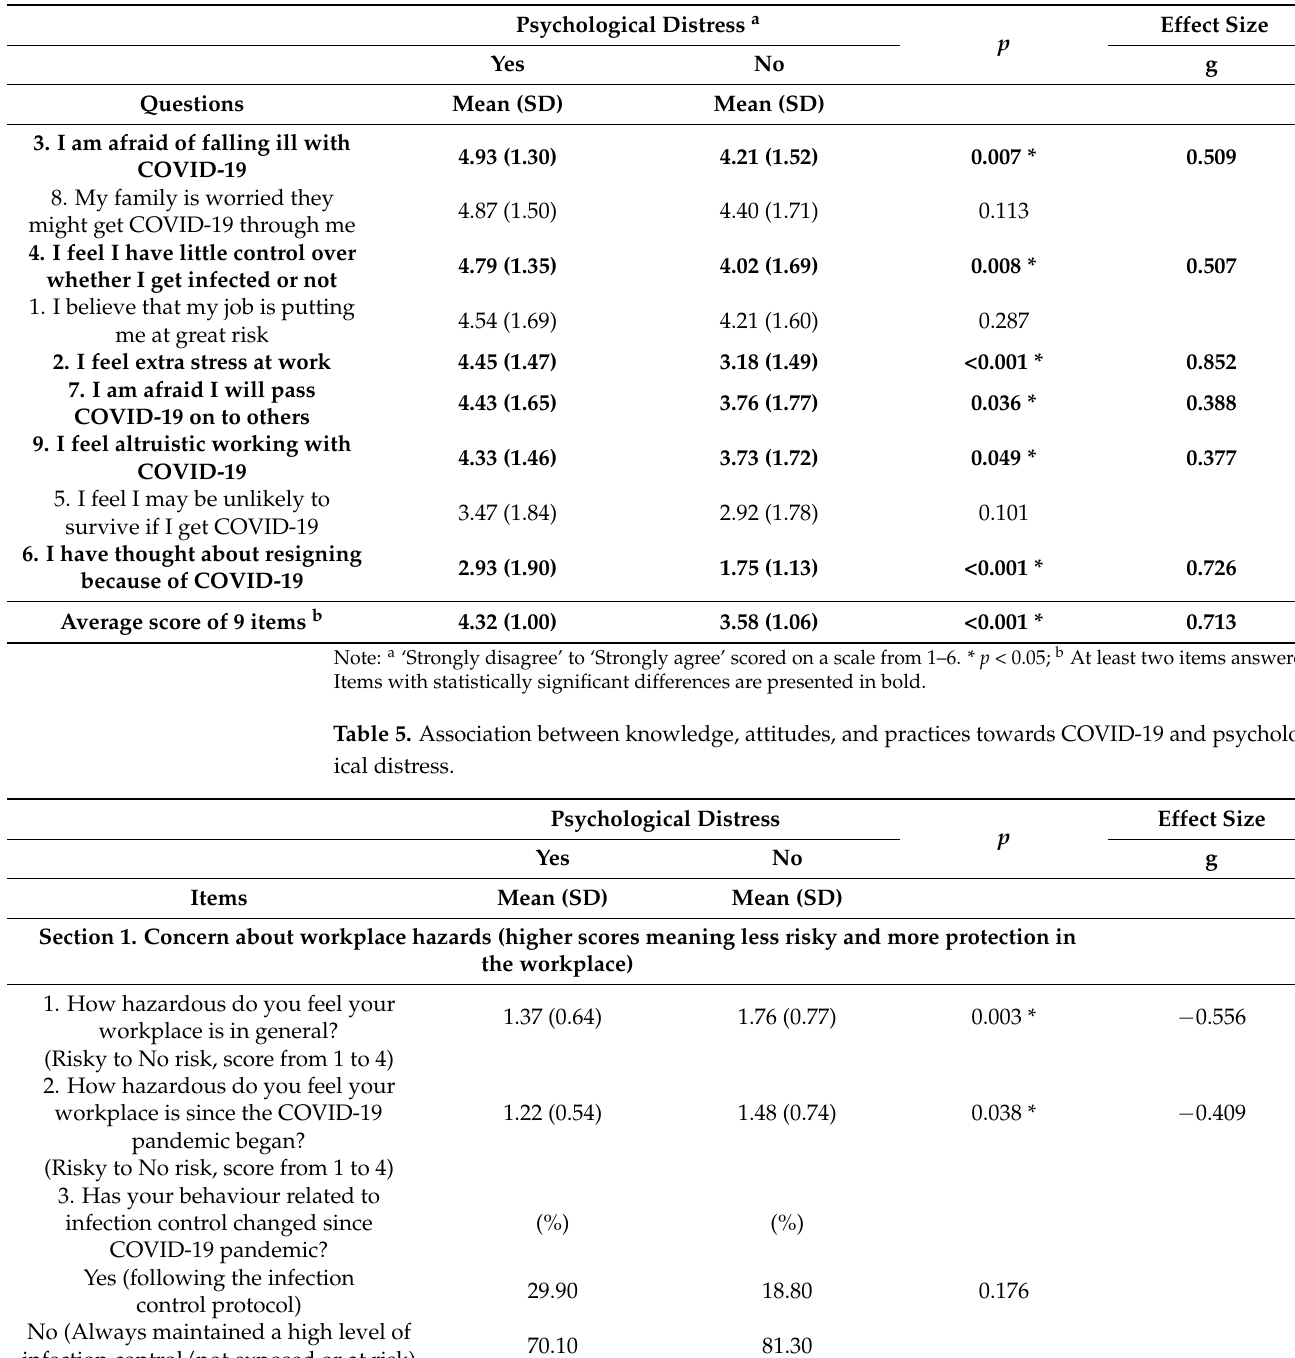
Table 4. Association between the perceived risks associated with COVID-19 and psychological distress.